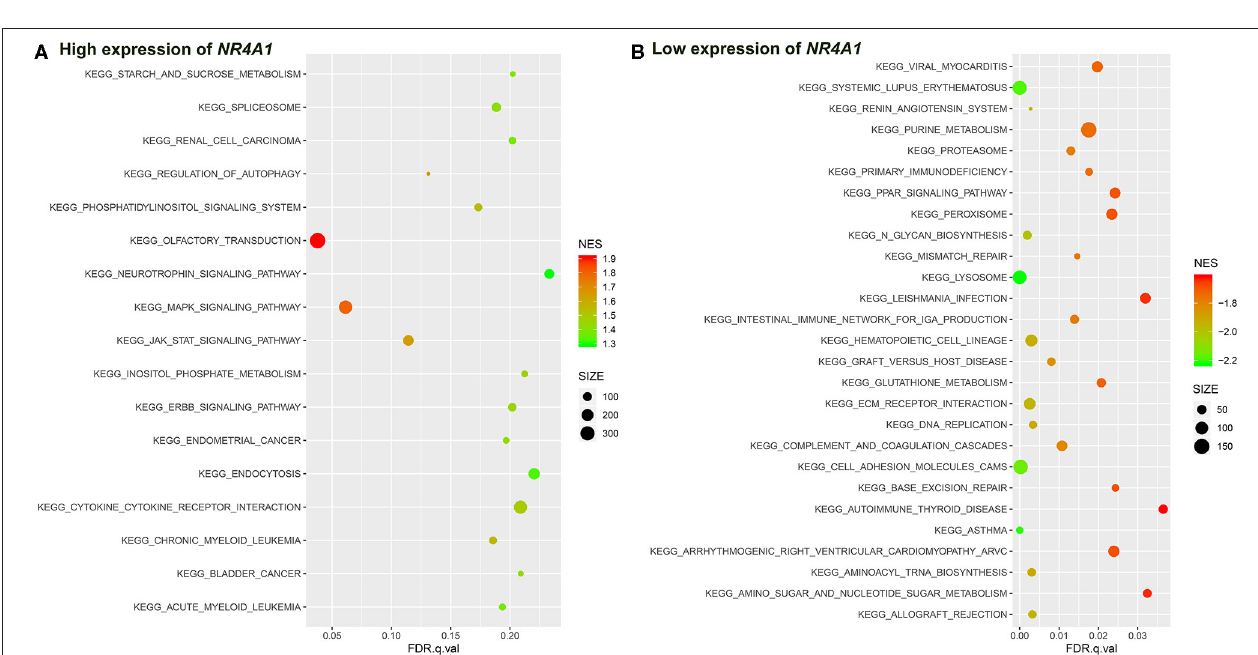
FIGURE 7 | The results of the GSEA on the biological processes. (A) Biological processes (Top 30) in the high expression of NR4A1 in AV fistula and (B) biological processes (Top30) in the low expression of NR4A1 in AV fistula. The size of the node represents the number of genes under the gene set. The color of the node represents the NES of the gene set. The horizontal axis represents the level of q -value.